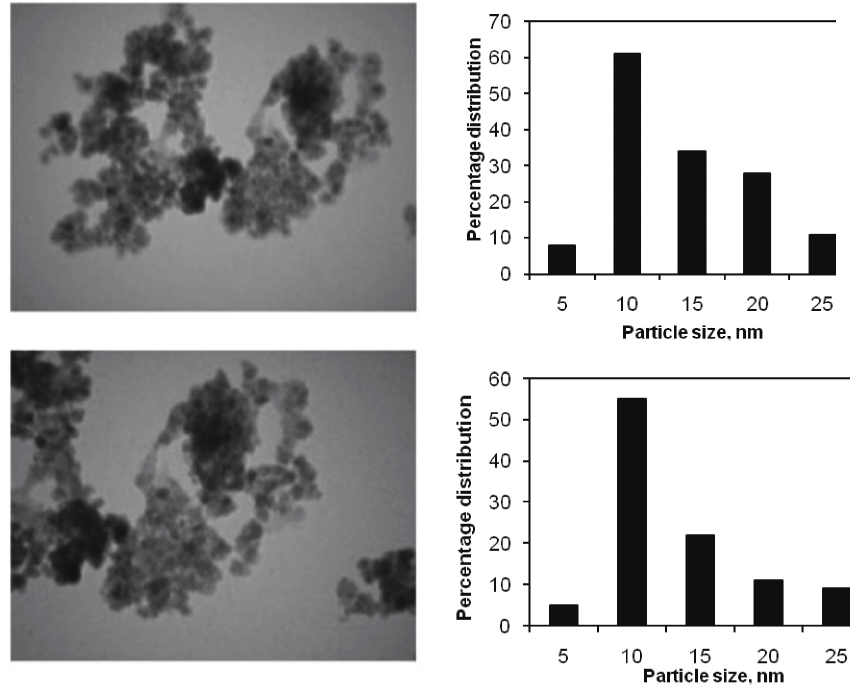
Fig. 4 – TEM images and related histograms of MHN